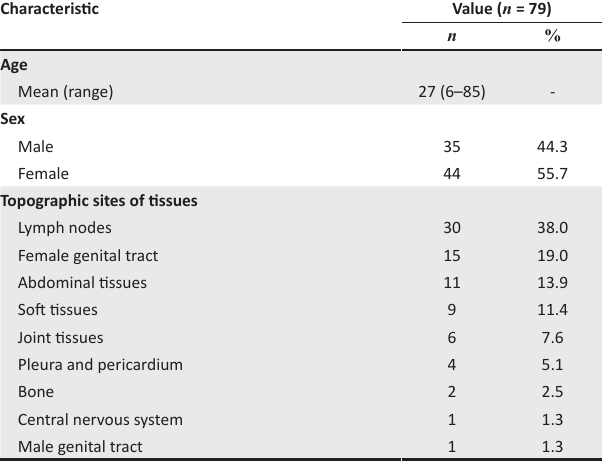
TABLE 1: Demographic and topographic sites of